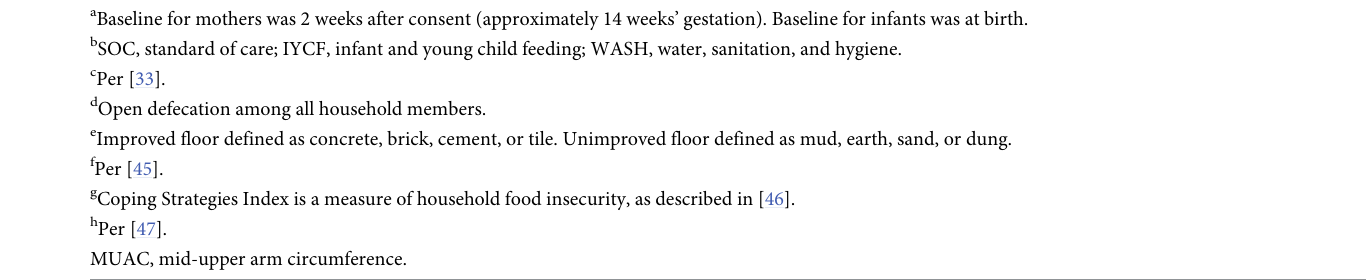
between the IYCF and WASH treatments; accordingly, we estimated the effects of the interven- tions by comparing the 2 IYCF groups with the 2 non-IYCF groups and the 2 WASH groups with the 2 non-WASH groups. The IYCF intervention had a small but significant effect on the total MDAT score (unadjusted difference 1.35, 95% CI 0.24, 2.46; p = 0.02), which was non-sig- nificant on adjustment (adjusted difference 0.79, 95% CI − 0.22, 1.60; p = 0.06). This effect size corresponds to a 0.15-SD increase in total MDAT score among children randomized to the IYCF intervention. The total MDAT score difference was driven by slightly higher scores in the language component (unadjusted difference 0.66, 95% CI 0.12, 1.19; p = 0.02) and social com- ponent (unadjusted difference 0.26, 95% CI 0.01, 0.51; p = 0.04) for children in the IYCF groups; both differences were attenuated in adjusted analyses (Table 4). We found no evidence that the WASH intervention affected the total MDAT score or any of its components. There was no impact of IYCF on the MacArthur–Bates CDI grammar checklist in unad- justed or adjusted analyses. The WASH intervention had no impact in unadjusted